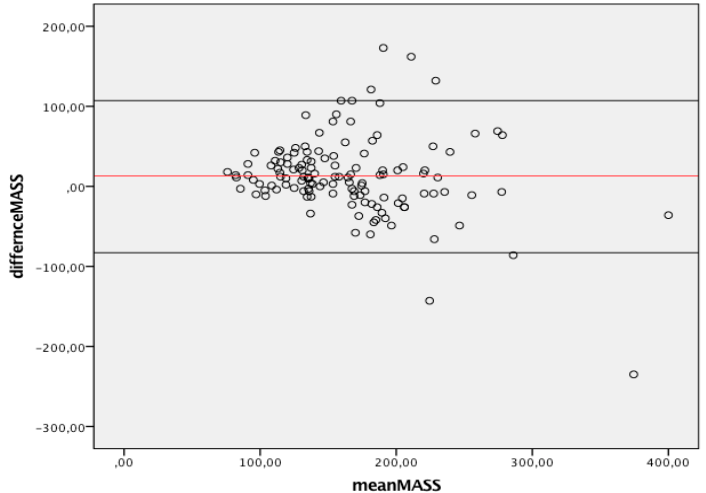
Figure 4. Bland-Altman graph. Y axes depicts difference between 2D and 3D same operator measured mass while X axis represents the average of measurements. Solid red line indicates average difference while black solid lines indicate 95%CI. CI, Confidence interval; 2D, two-dimensional; 3D, three-dimensional.